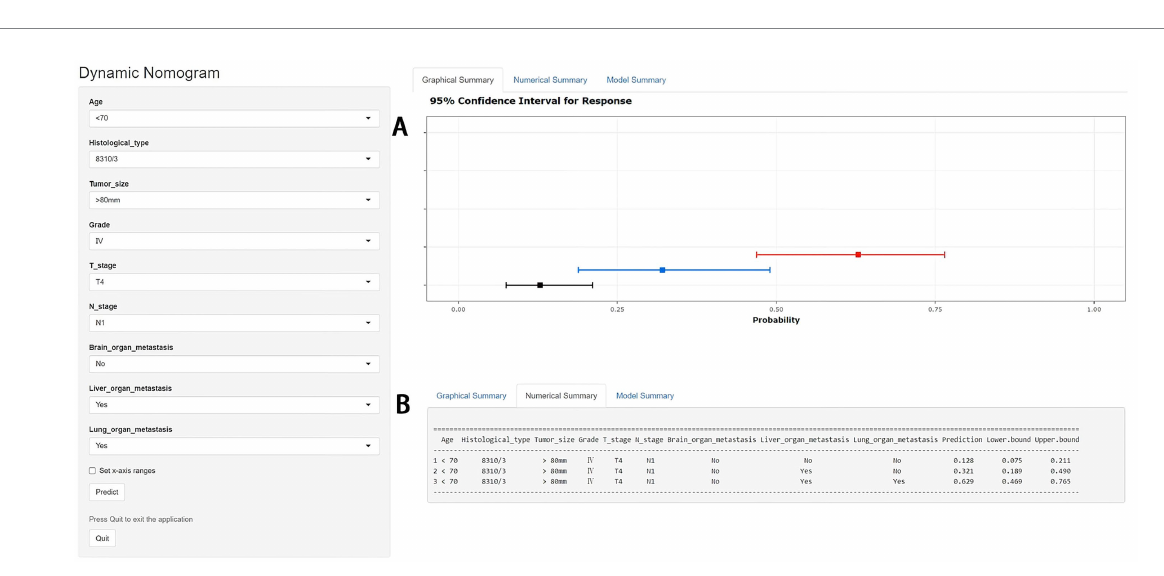
FIGURE 4 A web-based nomogram for predicting bone metastasis (BM) in an elderly kidney cancer (KC) patient (age: <70, histological type: 8310/3, tumor size: >80 mm, grade: IV, T stage: T4, N stage: N1). 95% confidence intervals of without brain/liver/lung metastasis, with liver metastasis and with liver/lung metastasis BM probabilities for this patient (A) . Numerical summary of without brain/liver/lung metastasis, with liver metastasis and with liver/lung metastasis BM probabilities for this patient (B) . Due to a large number of visitors to the webpage, if the application cannot be used normally, please click “Quilt” or “Reload” in the lower-left corner to try